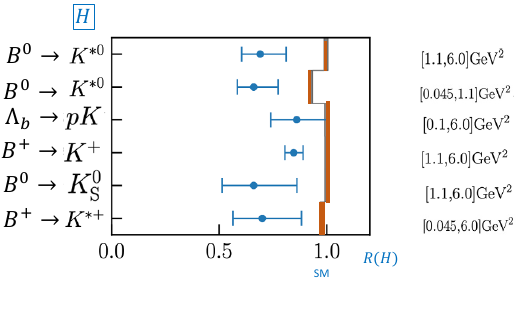
Figure 1. Current LHCb values for semileptonic ratios R ( H ), where the decaying particle is also indi- cated. The first two results are taken from [40], the baryon decay has been analyzed in [42], R ( K + ) in [37], and the last two measurements in